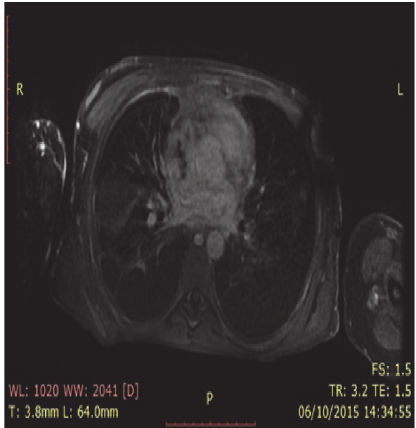
Figure 1: Cardiac MRI, thrombosis superior vena cava. Cross sec- tion of the cardiac MRI through the superior vena cava, the white ring shows thrombosis in the superior vena cava.